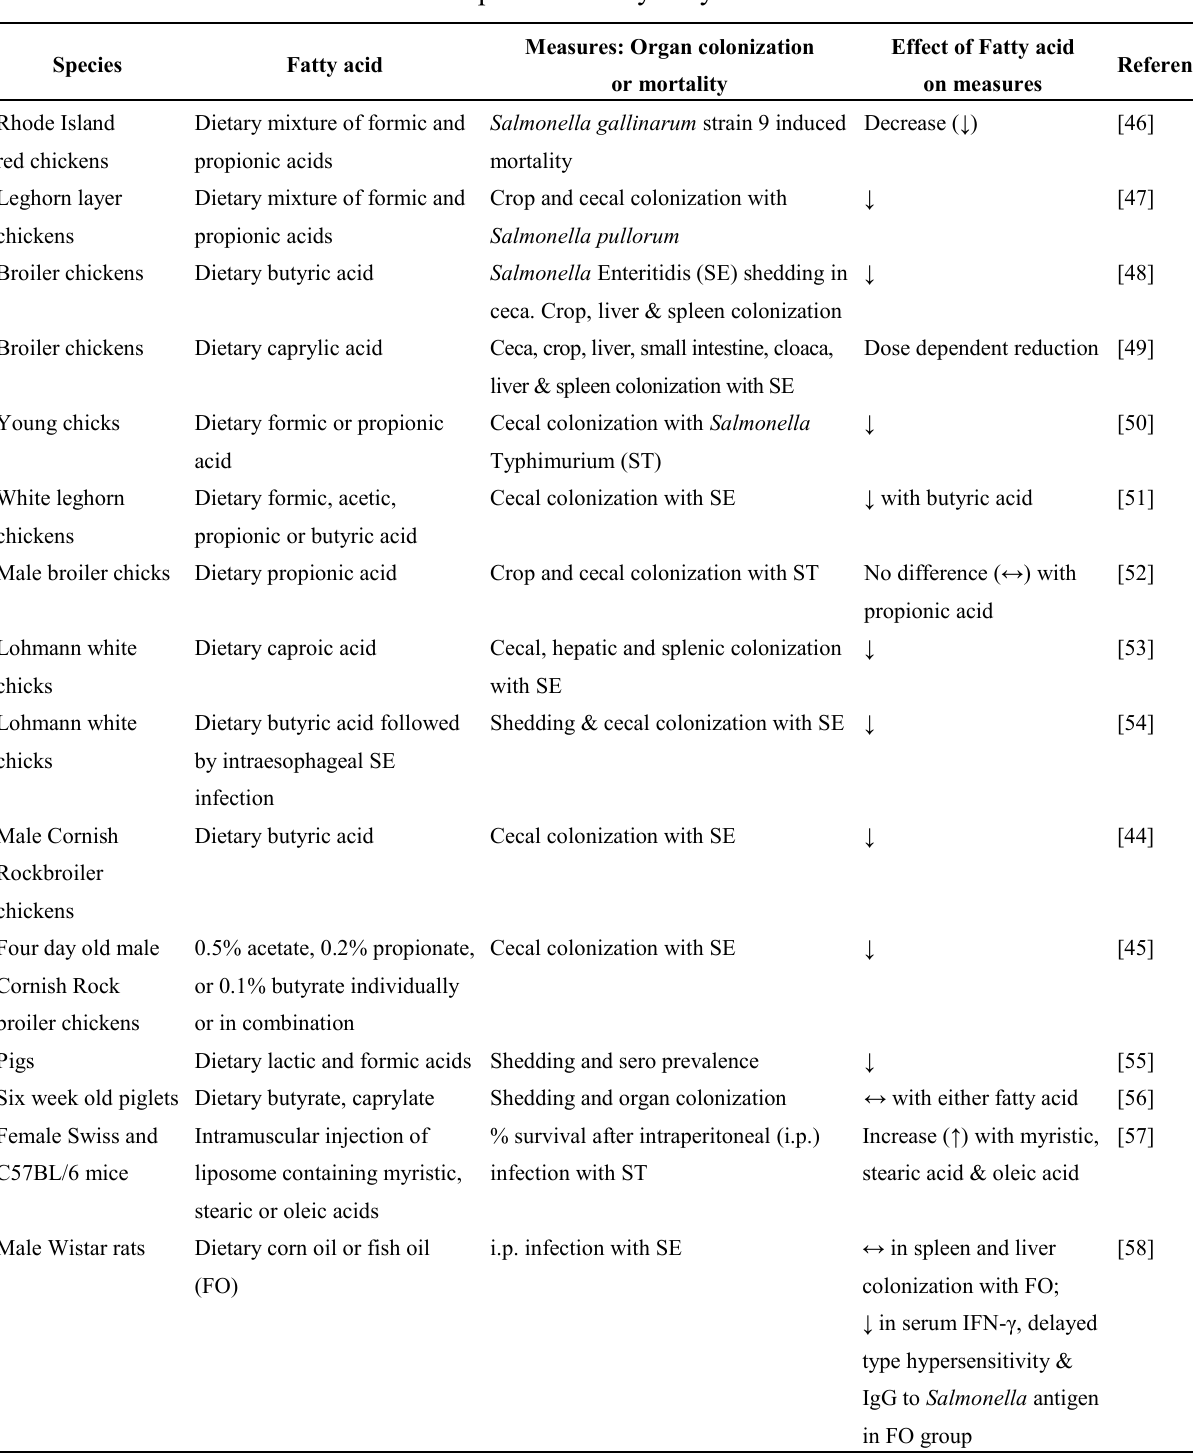
Table 1. In vivo studies: Impact of dietary fatty acids on Salmonella